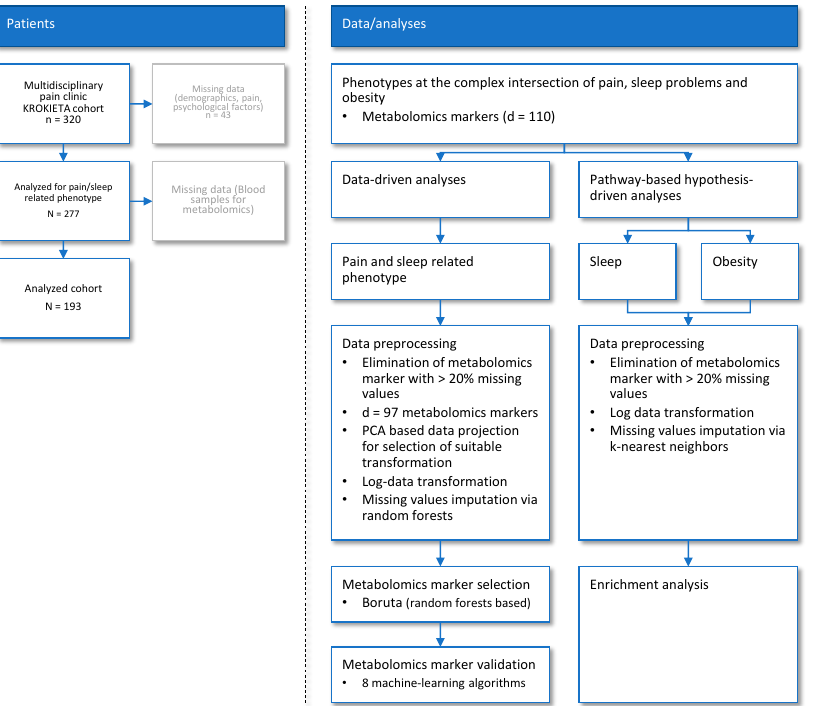
Figure 1. Flowchart showing number of patients and steps of data analysis. The data analysis followed two main lines: (i) A data-driven, unbiased approach to identify the most informative metabolomic markers for segregating patient subgroups in relation to the pain- and sleep-related phenotypes previously identified in the same cohort [13]; and (ii) a hypothesis-driven enrichment analysis examining metabolomic markers involved in sleep problems and obesity as main features of the patients’ clinical picture. The figure was created using Microsoft PowerPoint ® (Redmond, WA, USA) on Microsoft Windows 11 running in a virtual machine powered by VirtualBox 6.1 (Oracle Corporation, Austin, TX, USA). Table 1. Basic descriptive statistics of information in 53 parameters not primarily used for pain phenotype clustering [13], collected from the 193 patients included in the present analyses: patients’ demographics, living situation, other pains, medical treatment experiences and comorbidities, and lifestyle-related parameters. For ordinal and interval-scaled variables, medians with IQRs are re- ported; for categorical variables, the categories are shown with the counts of patients belonging to each. Raw non-imputed data are shown; counts < 193 indicate missing data for some